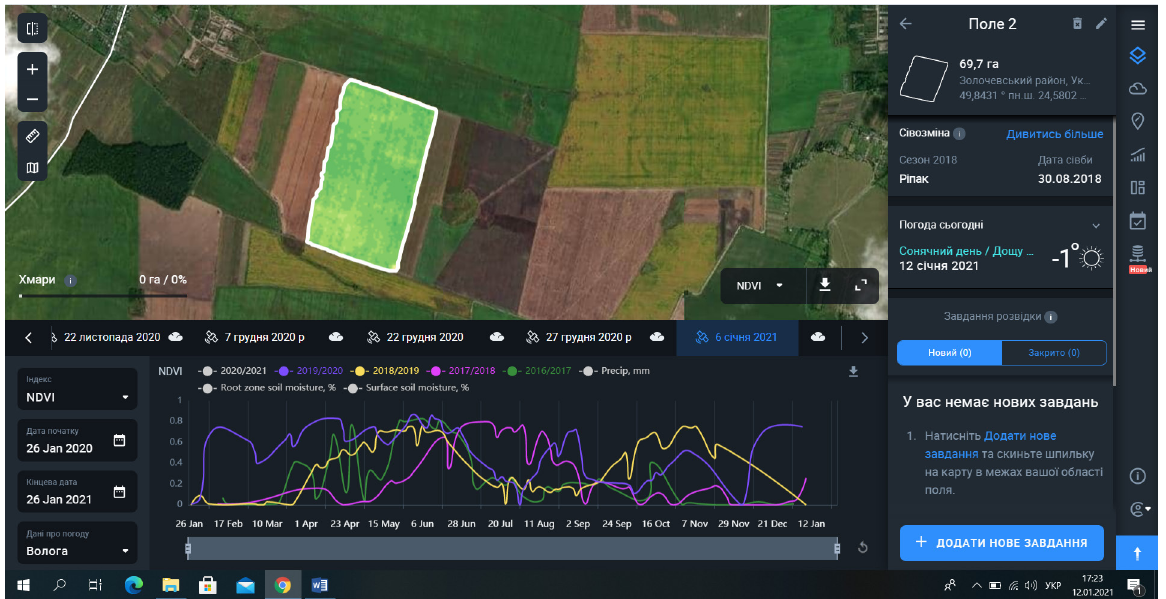
Figure 9. Comparison of the state of the neighboring area for land use object as to vegetation index NDVI on June 28 and July 16, 2019